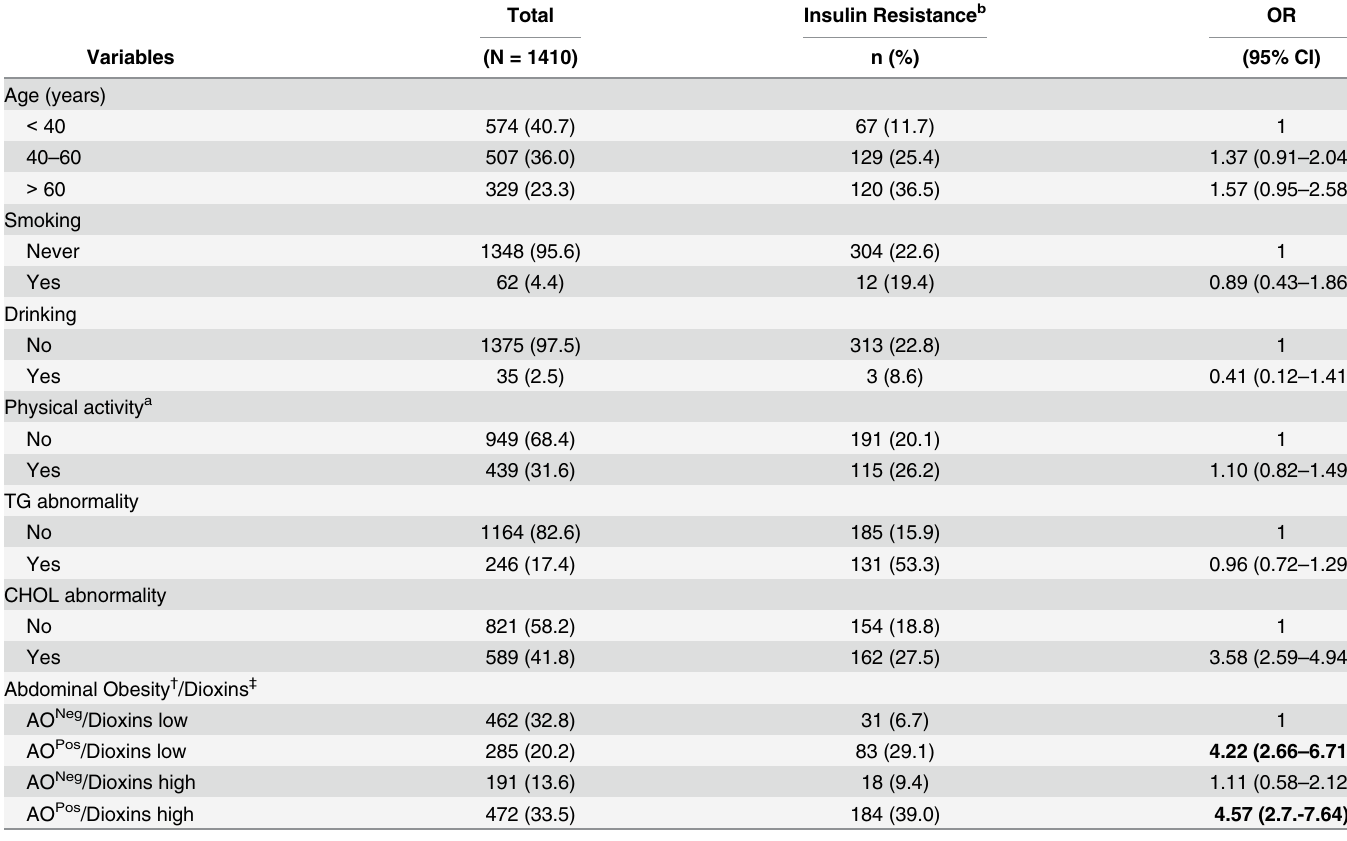
Table 6. Association between serum TEQ DF-1998 and the risk of insulin resistance in participants (Women = 1410). Total Insulin Resistance b